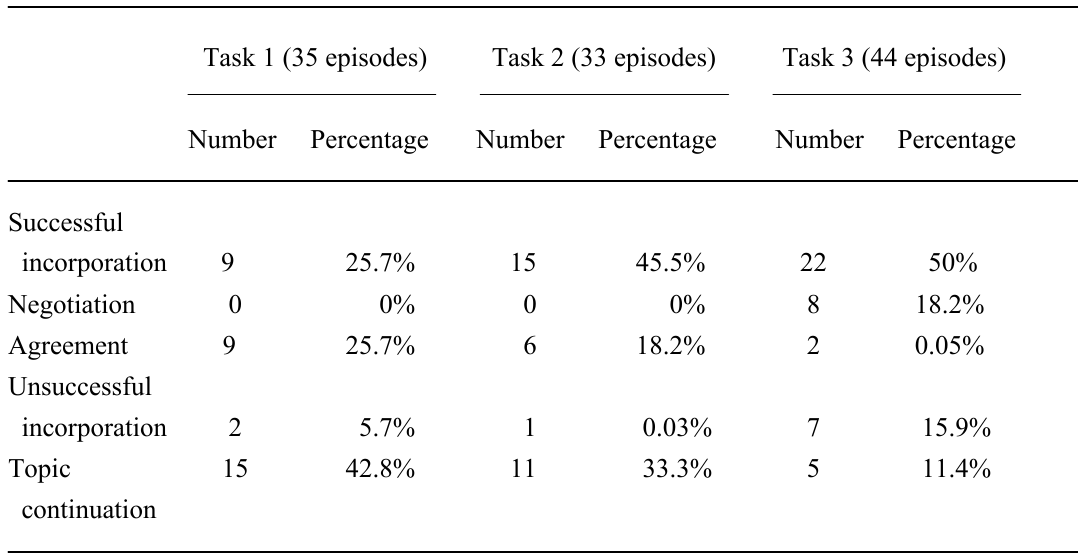
Learners’ reactions to recasts, by